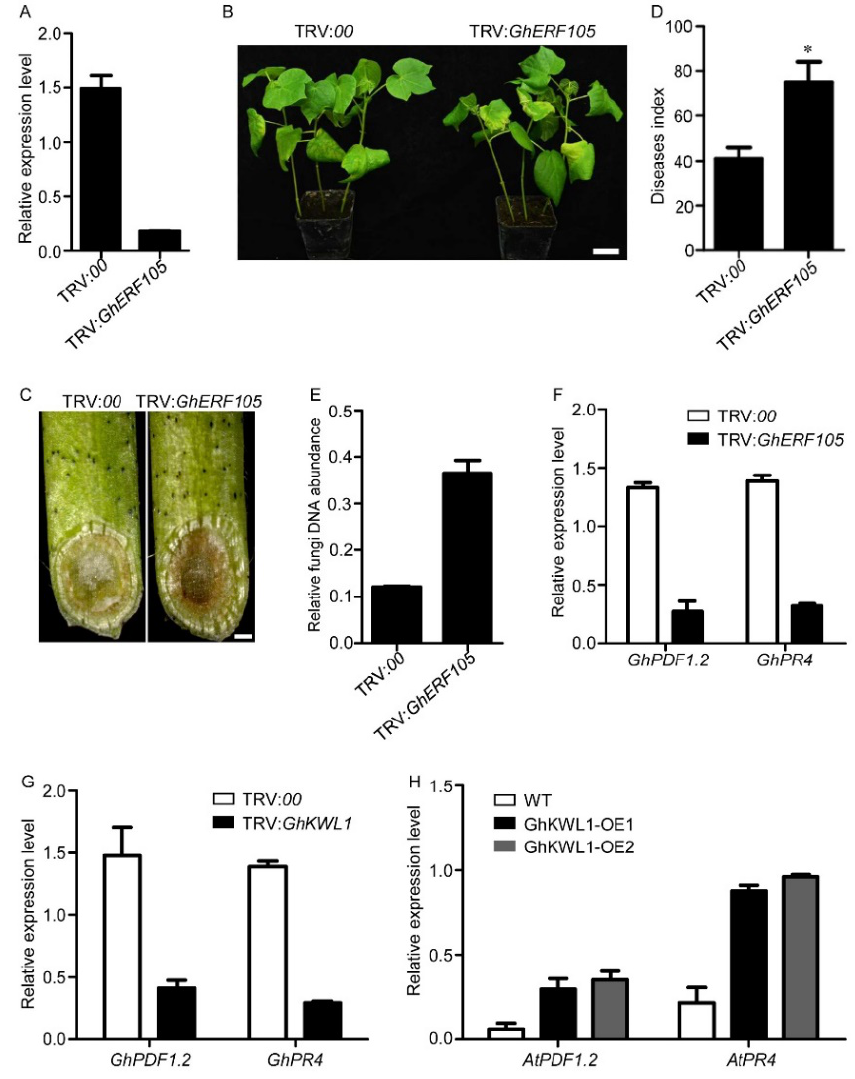
Figure 4. The downregulation of GhERF105 attenuates cotton resistance to V. dahliae infection. ( A ) The expression of GhERF105 in leaves of cotton plants after 2 weeks of virus-induced gene silencing of GhERF105 . ( B ) Disease symptoms of cotton plants at 20 d post-inoculation. The roots of cotton seedlings after 2 weeks of virus-induced gene silencing of GhERF105 were irrigated with 10 mL of V. dahliae conidial suspension (10 7 conidia/mL). The scale bar represents 3 cm. ( C ) Sections of TRV: 00 and TRV: GhERF105 cotton stems. The brown areas are diseased vascular bundles. The scale bar represents 1 mm. ( D ) The disease index of TRV: 00 and TRV: GhERF105 plants at 20 dpi. Three independent replicates were performed, with at least 20 plants being measured per VIGS event and replicate. Asterisks indicate statistical significance as determined by Student’s t -test (* p < 0.05). ( E ) Fungal DNA abundance in leaves of TRV: 00 and TRV: GhERF105 cotton. The DNA was isolated from cotton leaves at 20 dpi. ( F ) Expression levels of GhPDF1.2 and GhPR4 in TRV: 00 and TRV: GhERF105 cotton plants. Total RNAs were extracted from the cotton leaves after 2 weeks of virus-induced gene silencing of GhERF105 . ( G ) Expression levels of GhPDF1.2 and GhPR4 in TRV: 00 and TRV: GhKWL1 cotton plants. Total RNAs were extracted from the cotton leaves after 2 weeks of virus-induced gene silencing of GhKWL1 . ( H ) Expression levels of AtPDF1.2 and AtPR4 in wild-type Arabidopsis and 35S : GhKWL1 transgenic Arabidopsis lines. Total RNAs were extracted from 3-week-old Arabidopsis leaves. The relative level was determined by quantitative RT-PCR ( A , E – H ). GhUBQ7 served as the reference gene in cotton ( A , E , F ); AtACTIN2 served as the reference gene in Arabidopsis ( H ).